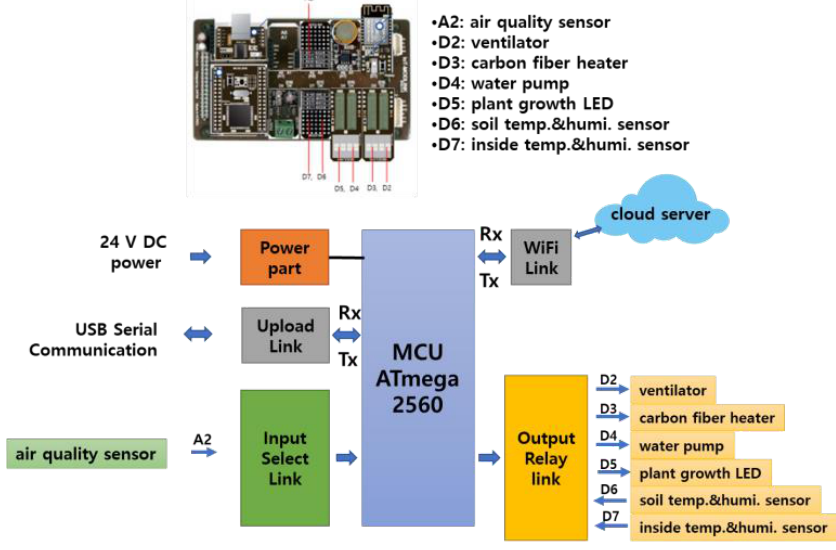
Figure 11. Interface design and block diagram.